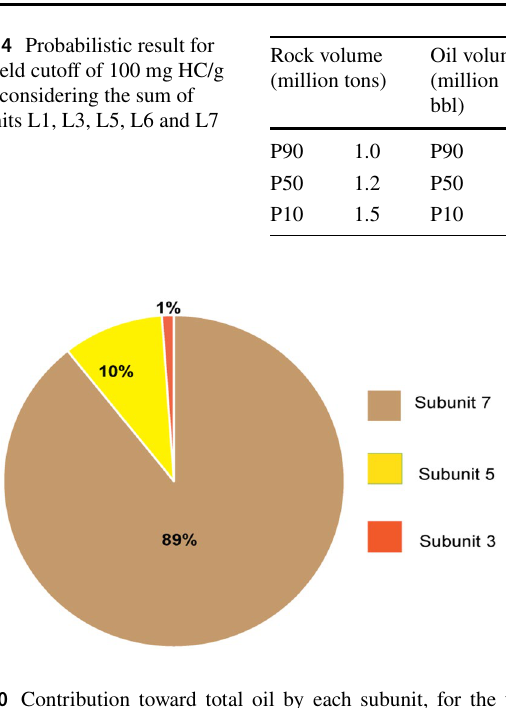
Fig. 10 Contribution toward total oil by each subunit, for the yield cutoff of 100 mg HC/g rock